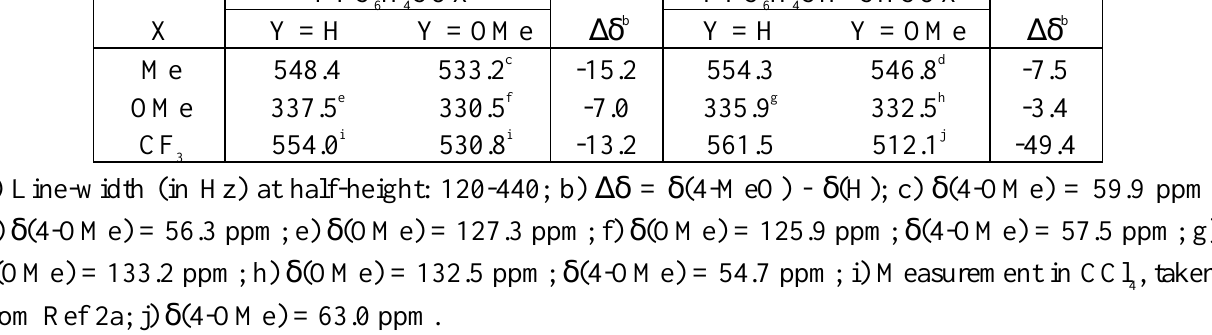
Table 3. 17 O NMR data of 4-YC